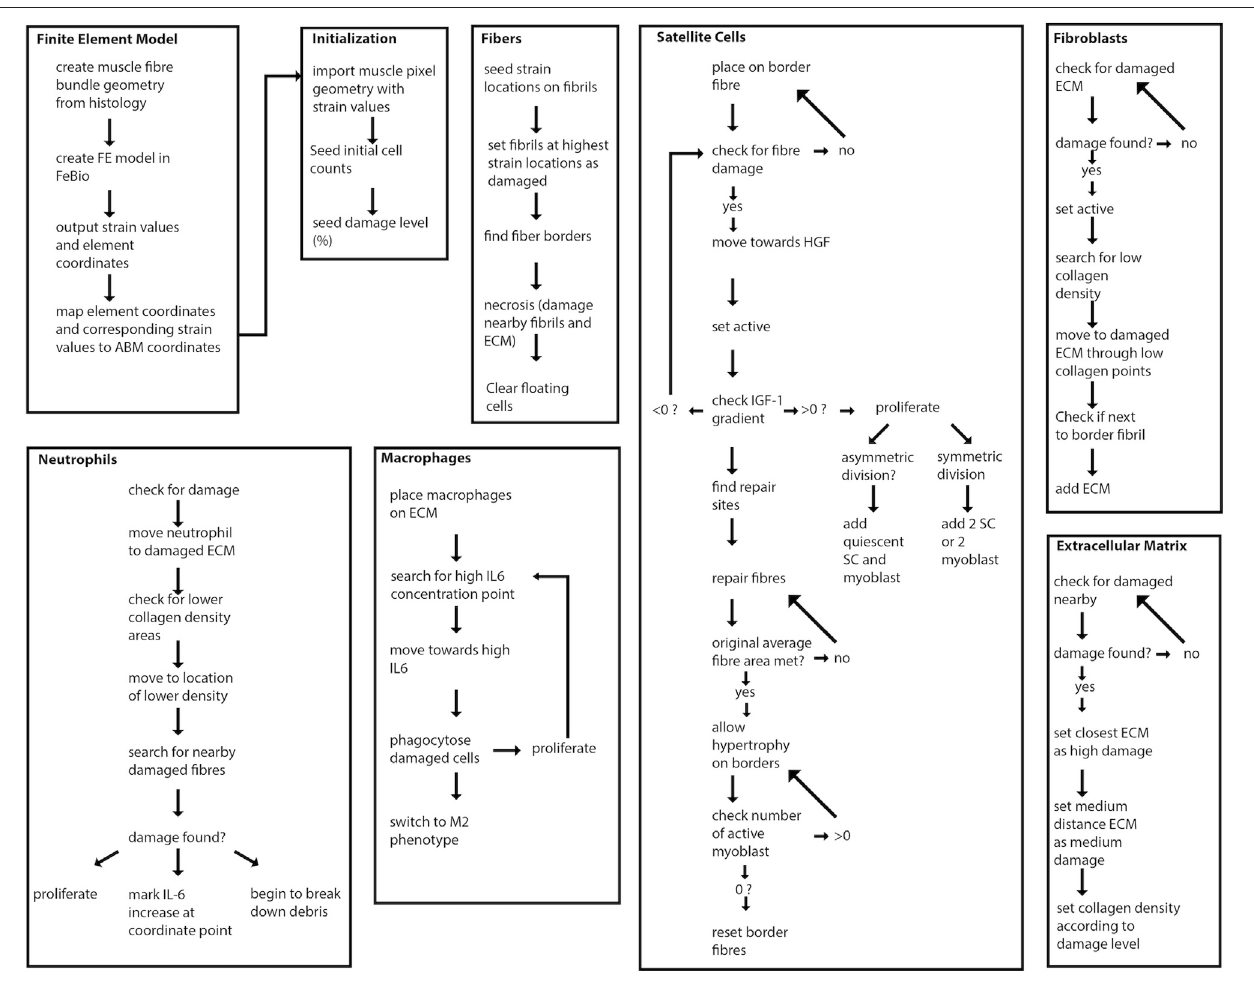
FIGURE 2 | Overview of agent-based model steps. FE model resultant strains are mapped from each element center coordinate to the corresponding pixel coordinates of fi brils in the agent-based model. Fibers, SCs, neutrophils, macrophages, fi broblasts and ECM components work to regenerate damaged tissue.